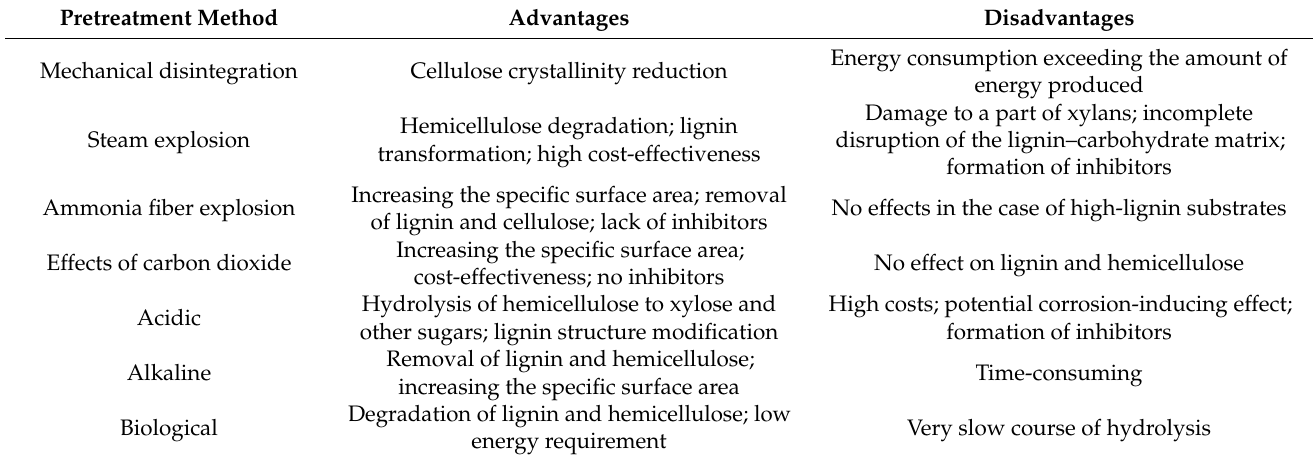
Table 1. Disadvantages and advantages of pretreatment of lignocellulosic substrates